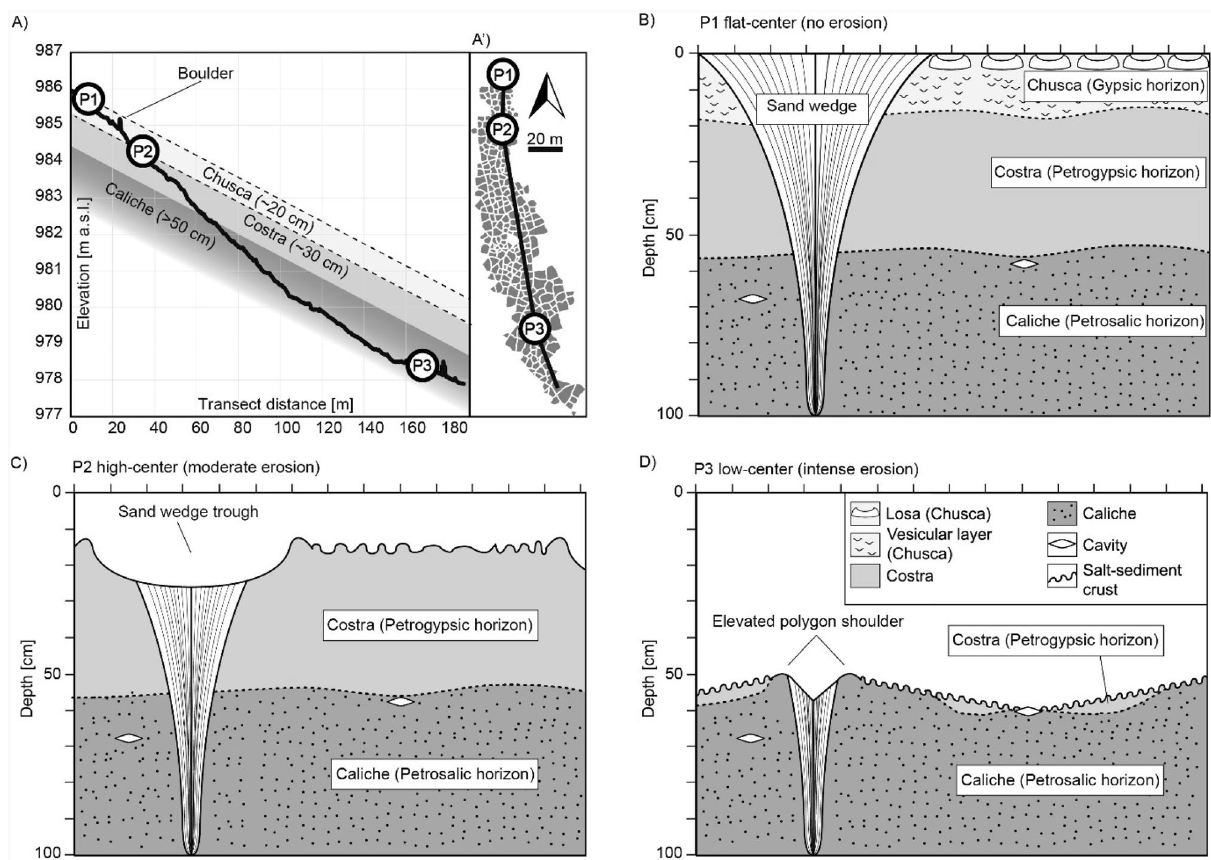
Figure 3. Conceptual interpretation of polygonal network (PN) erosion in the Atacama Desert. ( A ) Slope profile (black line) along the PN with sample locations (P1, P2, P3) and the common soil horizons (schematic illustration, not to scale). (A’) The profile position (black line) along the PN (grey). ( B ) The flat-center P1 polygons represent non-eroded polygons; modified from 25 ( C ) The high-center P2 polygons with moderate erosion (0.2 m) exposing the costra horizon. ( D ) The low-center P3 polygons with intense erosion (0.5 m) exposing the deeper caliche